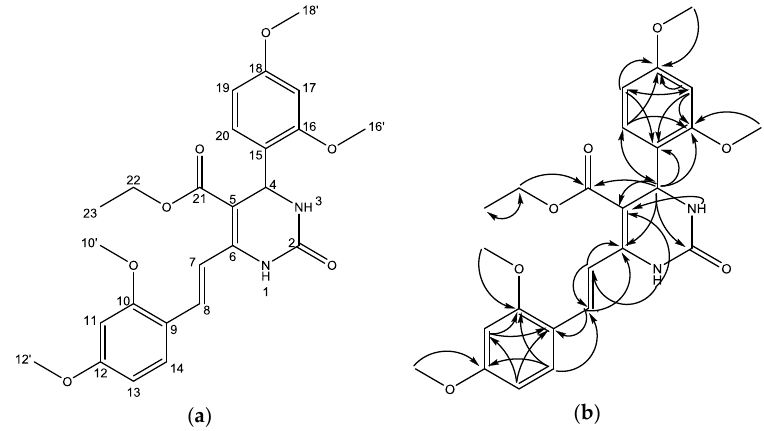
Figure 3. ( a ) Numbering of the structure, and ( b ) Selected HMBC correlations for compound 2